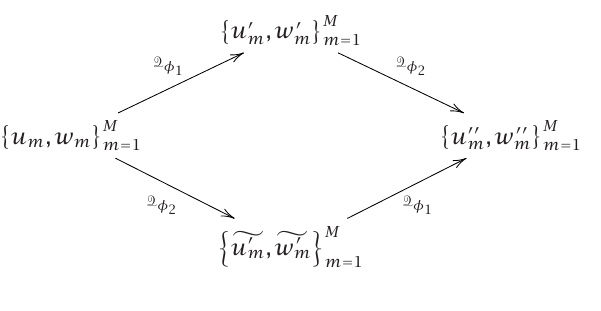
(cid:1) φ 1 and φ 2